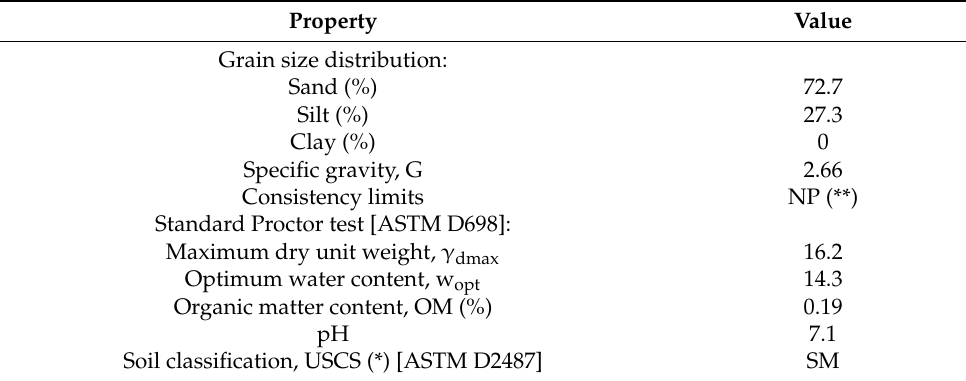
Figure 1. Grain size distribution of the soil used. Table 1. Main characteristics of the soil used in the